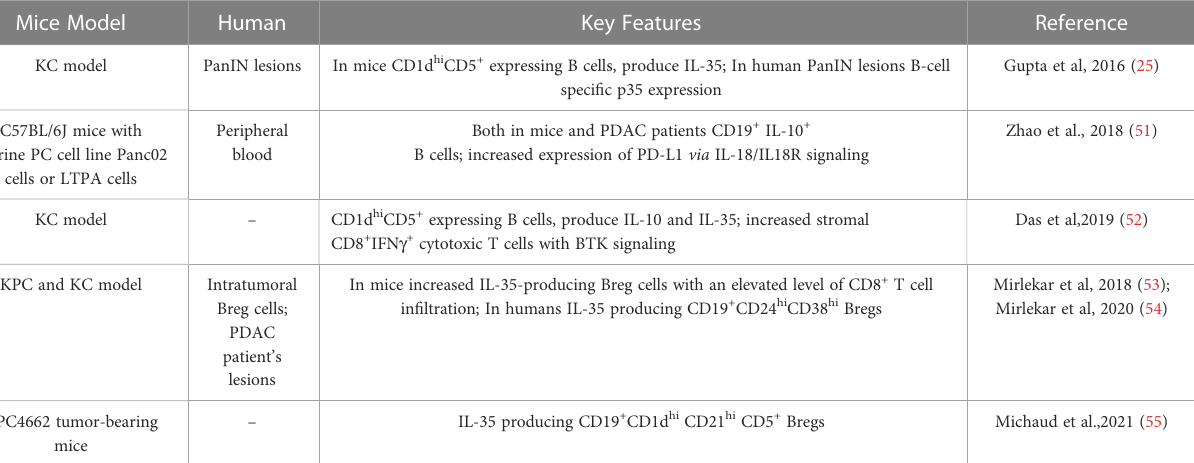
TABLE 1 Bregs in the